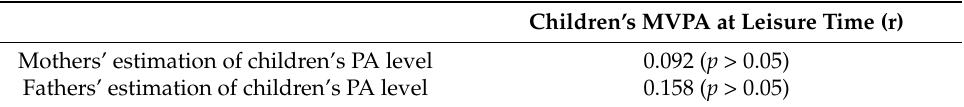
Table 3. Pearson correlations between parents’ estimation of their children’s PA level at leisure time and the children’s objectively-measured PA level at leisure time.